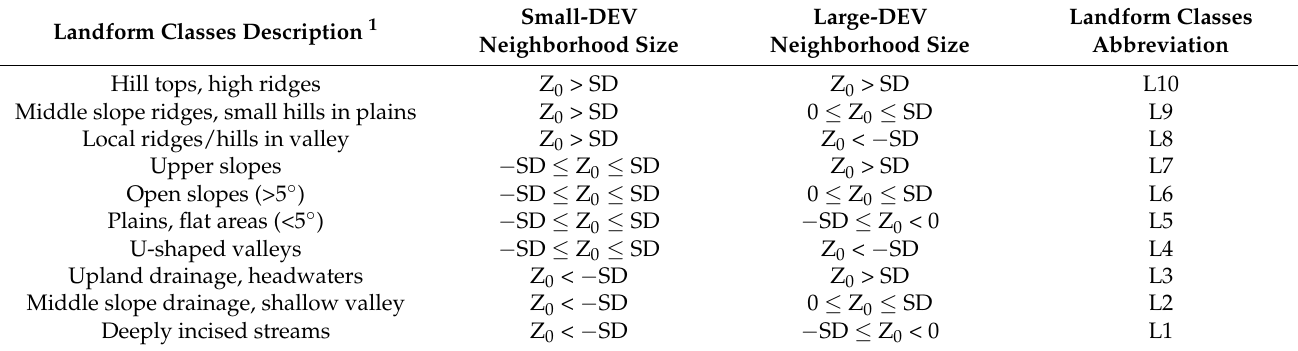
Table 2. Descriptions and abbreviations of landform classes used for habitation practices characteri- zation during the LBA in the Jijia catchment, obtained based on combined small-DEV and large-DEV neighborhood sizes (second